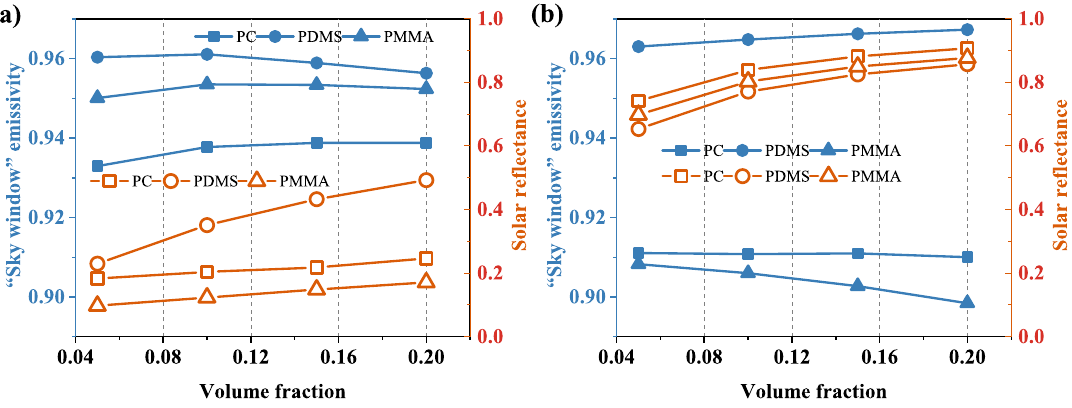
Figure 3. Effect of volume fraction on the radiative properties of different structures. ( a ) RDSP structure and ( b ) porous